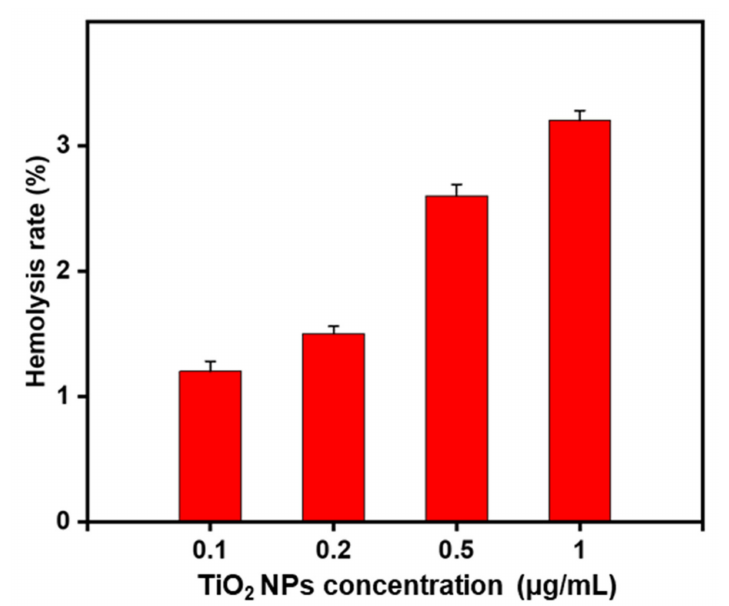
Figure 8. Hemolysis rate (%) of RBCs (2% v/v ) treated for 2 h (at 37 ◦ C) with the biosynthesized TiO 2 NPs at various indicated concentrations. ddH20 was used as PC and PBS (1X, pH 7.4) was used as